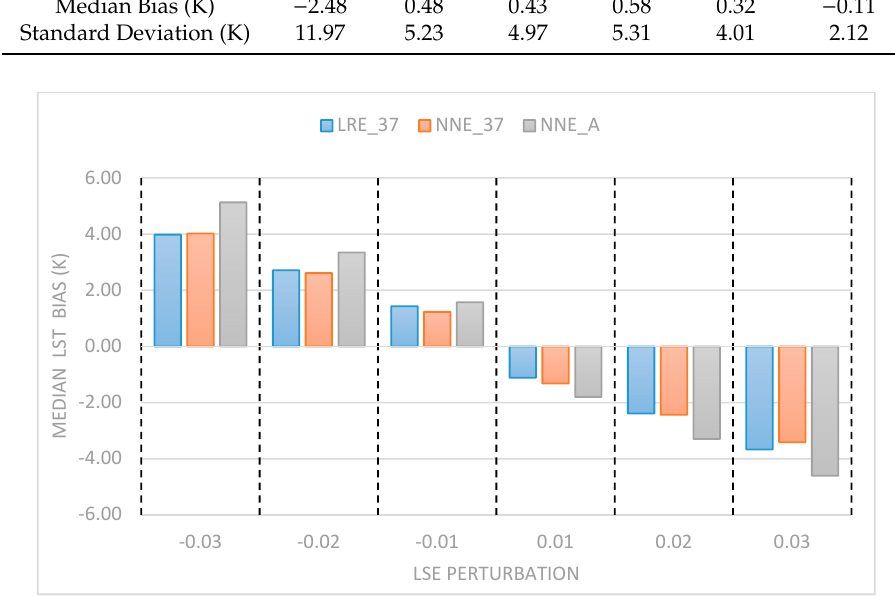
Figure 9. The median LST biases (K) for the LRE_37, NNE_37 and NNE_A algorithms (which explicitly ingest LSE) for set perturbations of LSE. Perturbation difference from the value given to the algorithm as opposed to the actual value of the pixel in the dataset.